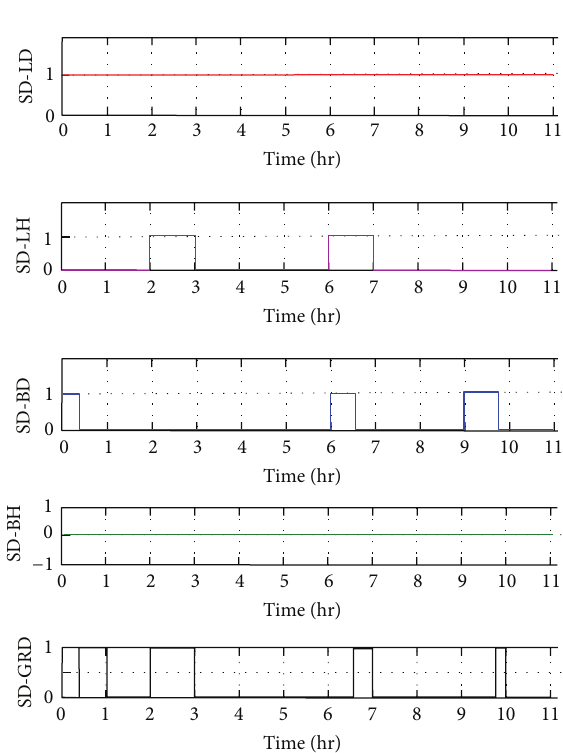
Figure 12: Switching operations of solar department agent